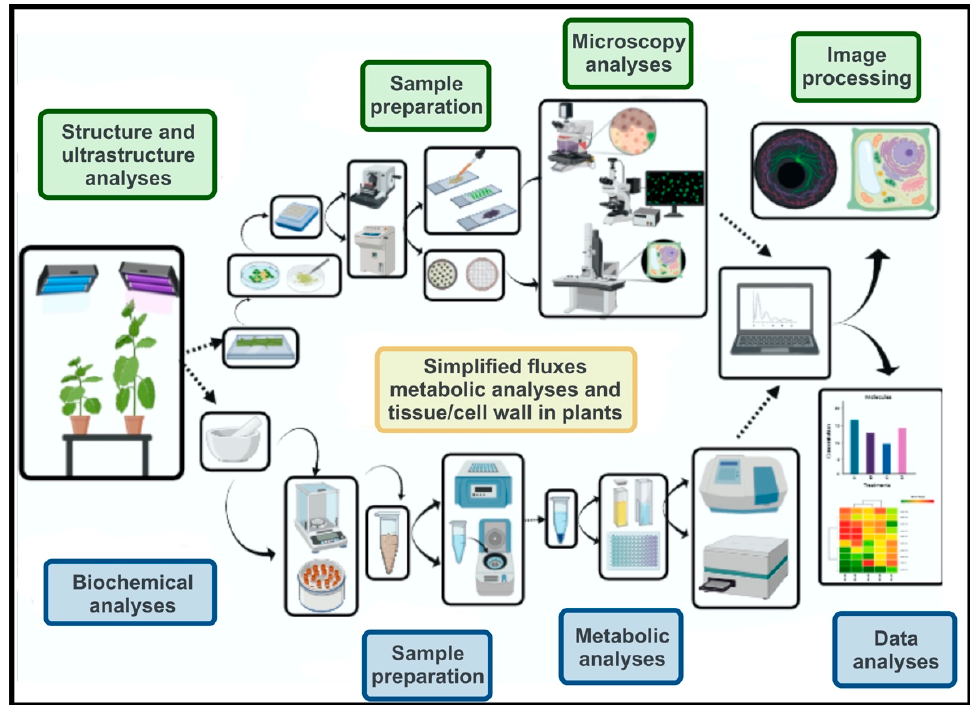
Figure 1. The schematic representation of an integrated analysis between the structural and ul- trastructural components of the cell wall using different microscopy techniques and biochemical analyses. The collected data were processed using qualitative and quantitative analyses, following the implementation of fixation and extraction methods. The samples were processed using different tools, equipment and techniques. Structural analyses were carried out using various microscopy techniques; metabolic analyses were performed using spectrophotometers or microplate readers. The data were processed and analysed using image software and statistical packages. These procedures are described in detail in the “Materials and Methods” section.